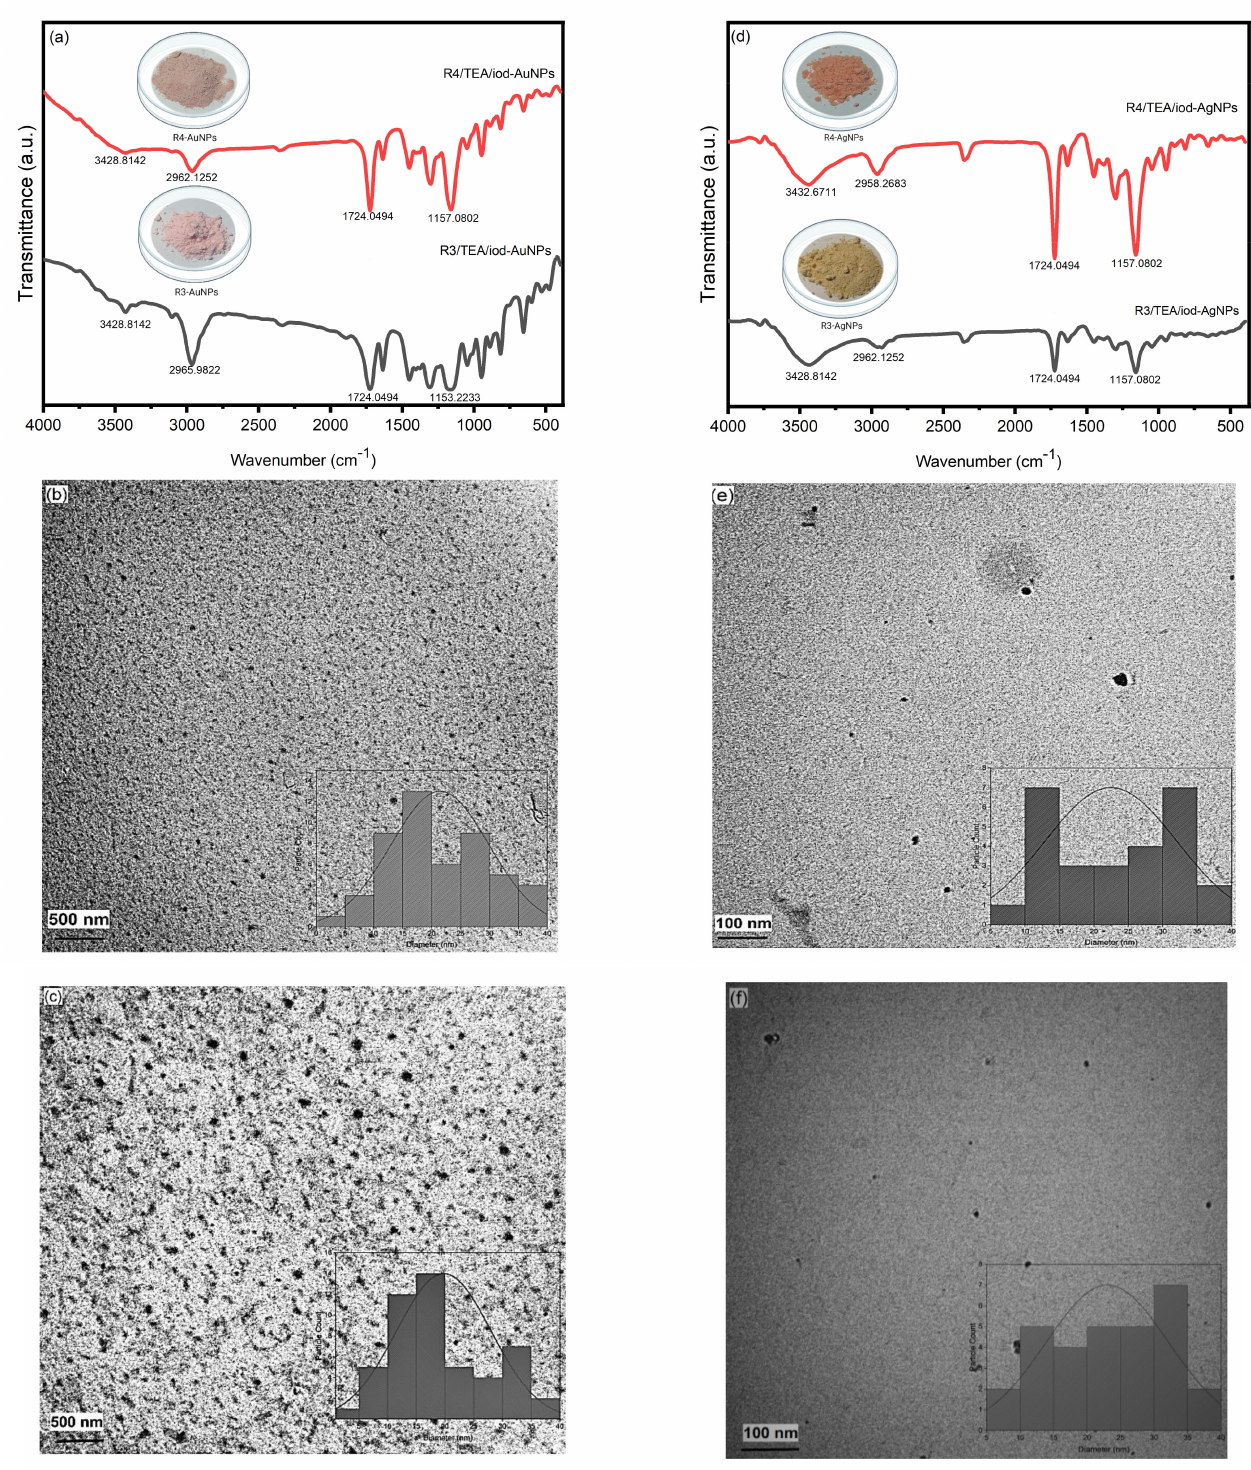
Figure 8. FT-IR spectrum of (R3 and R4) Complexes, AuNPs and AgNPs with Iod 1 wt%, TEA 0.2 wt%, ( a ) is R3–4 AuNPs and ( d ) is R3–4 AgNPs. TEM image of gold and silver nanoparticles in the polymer matrix complexes R4 and R3 0.2 wt%. ( b ) is R3(AuNPs+Iod), ( c ) R4(AuNPs+Iod), ( e ) R4(AgNPs+Iod)), ( f ) R3(AgNPs+Iod). AgNO 3 2 wt%, gold chloride 3 wt%, and TEA 0.2 wt% dissolved in EGDA 95.6